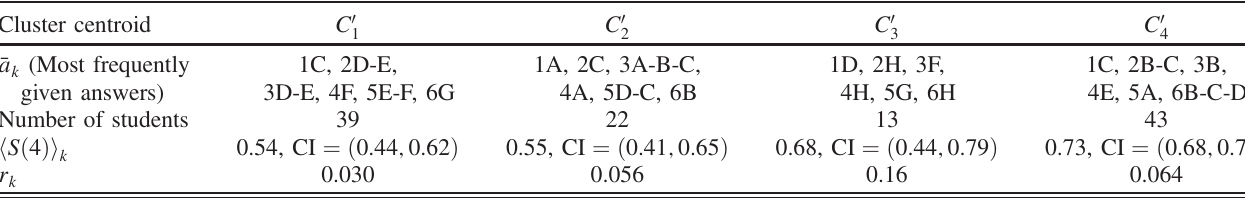
TABLE IV. An overview of results obtained by the NH -CLA method: 4-cluster solution. Cluster